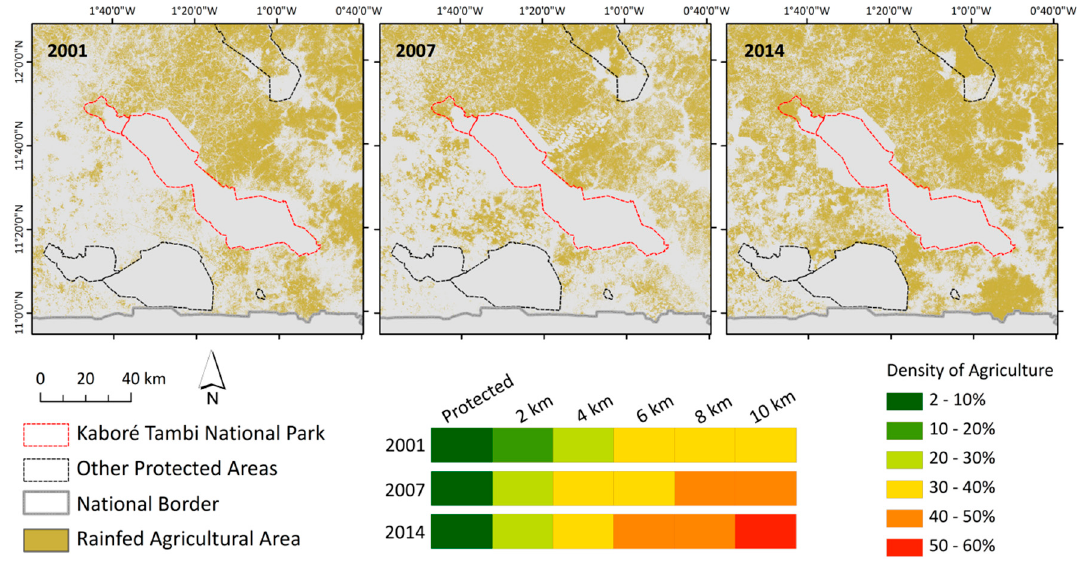
Figure 12. Maps of agricultural area in the Kaboré Tambi National Park and its surroundings for 2001, 2007, and 2014 ( top ) and plot of the development of agricultural area in the protected area and in 2 km distance zones around it between 2001 and 2014 ( bottom ); Location of focus area within Burkina Faso is marked in Figure 3.